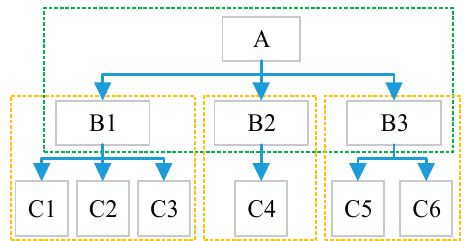
Figure 1. The unit division in a three-layered structure.